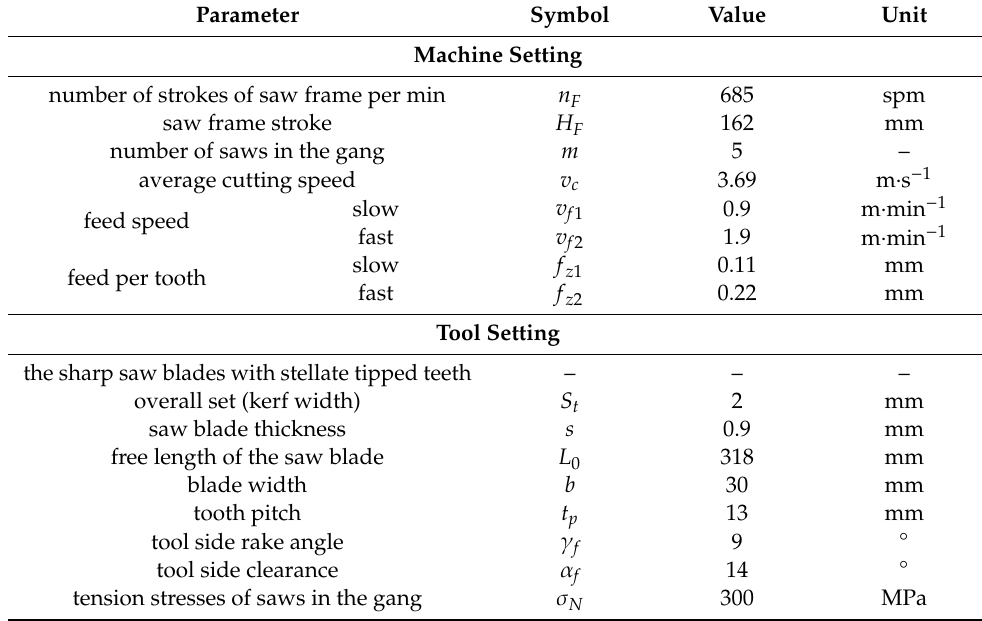
Table 2. Settings of the sash-gang saw, and its saw blade as used in the experimental cuttings.